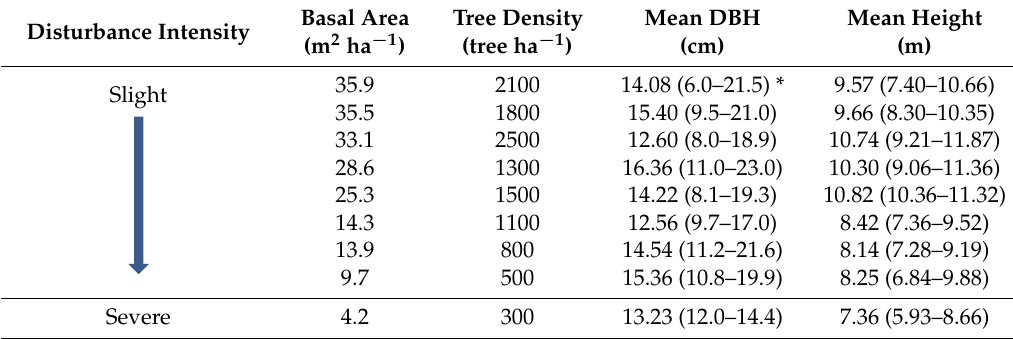
Table 1. Stand characteristics in pine wilt disease disturbed stands.